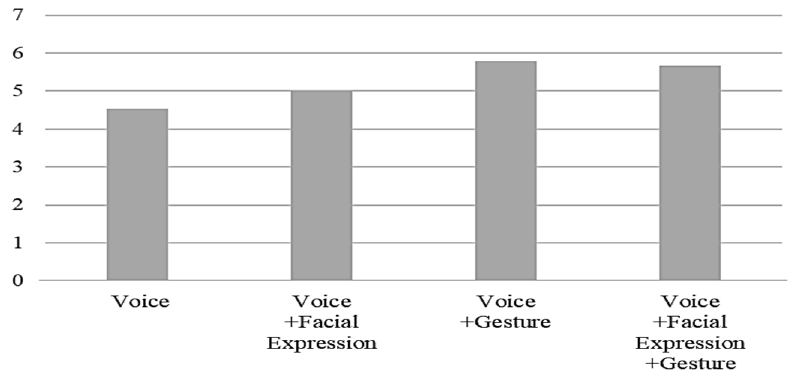
Figure 7. The degree to which the robot was perceived to have emotions by interaction type.